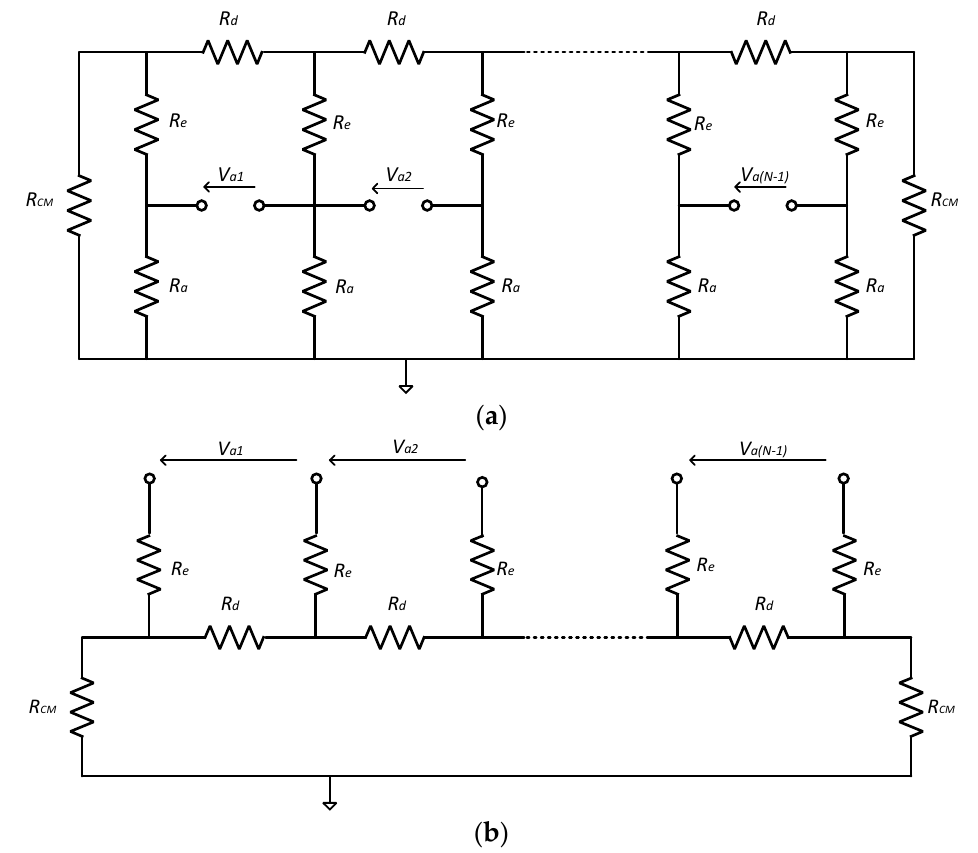
Figure 3. ( a ). Passband equivalent circuit for thermal noise analysis. This is a ladder expansion of the circuit of Figure 2a, i.e., for a Type 1 circuit. ( b ). The circuit of ( a ) with the resistors R a is removed to reflect the fact that they appear in parallel with much smaller resistors and therefore contribute little to the thermal noise calculation.